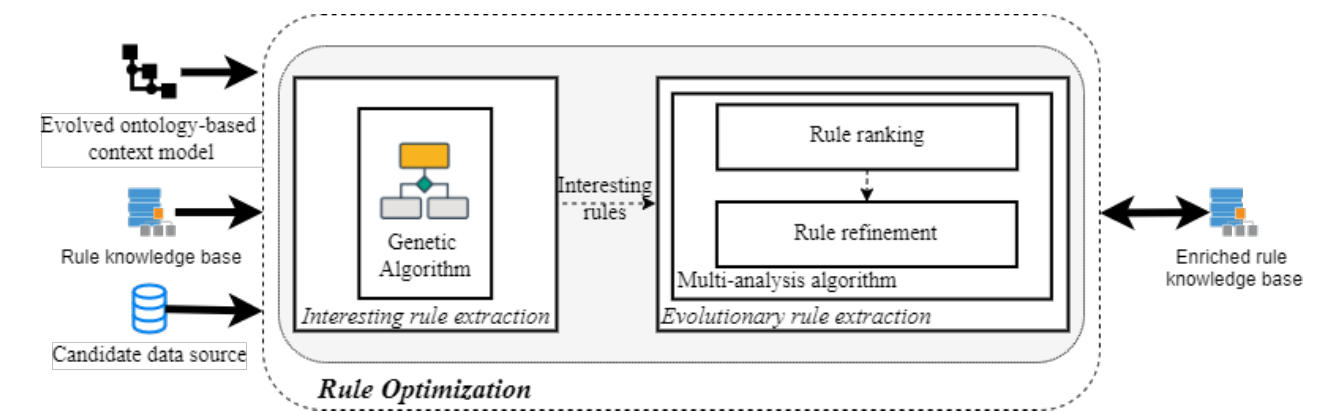
Figure 4. Learning-based rule generation